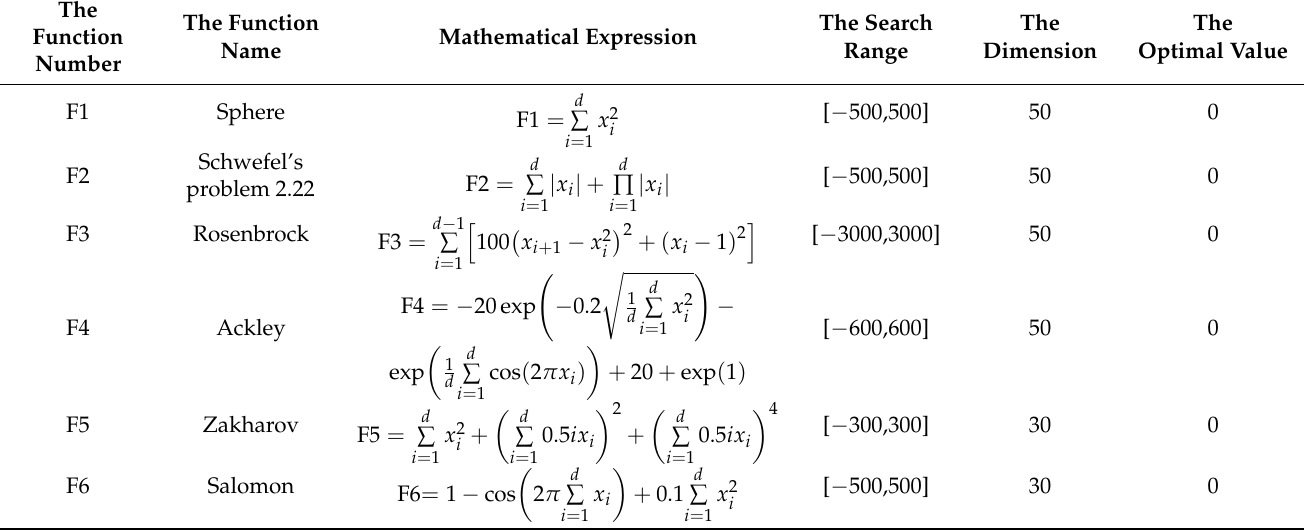
Table 1. Test functions and